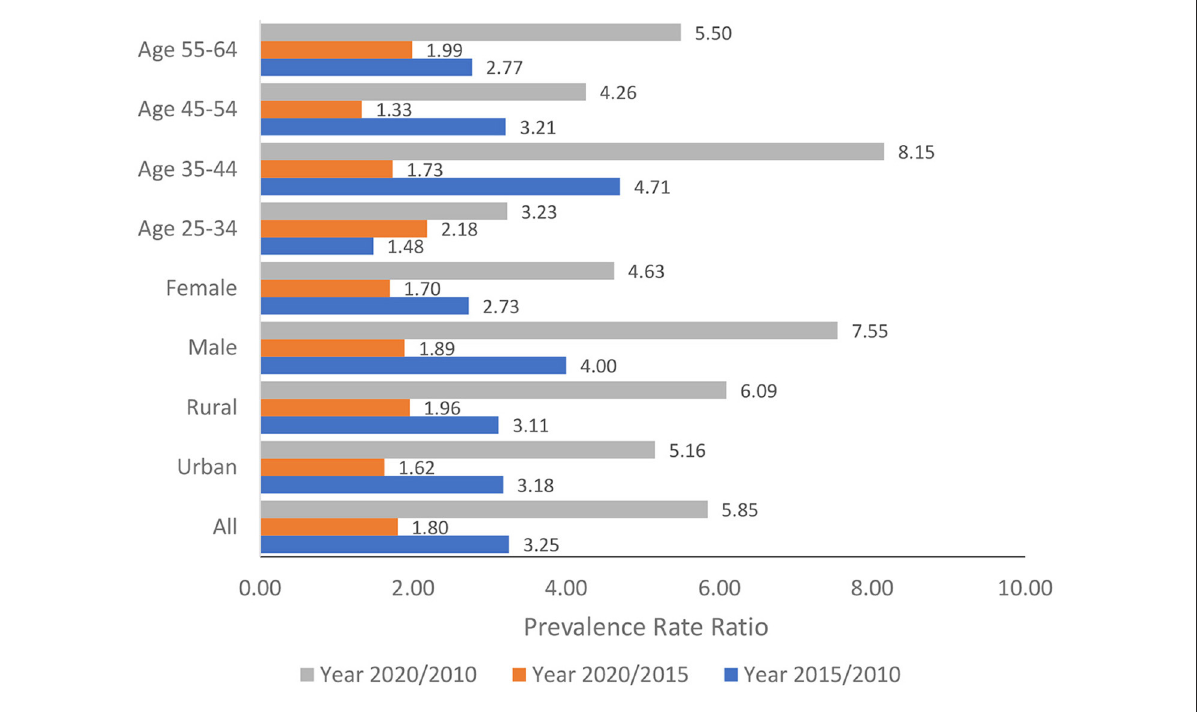
FIGURE3 Relative changes in the prevalence of increased blood glucose over